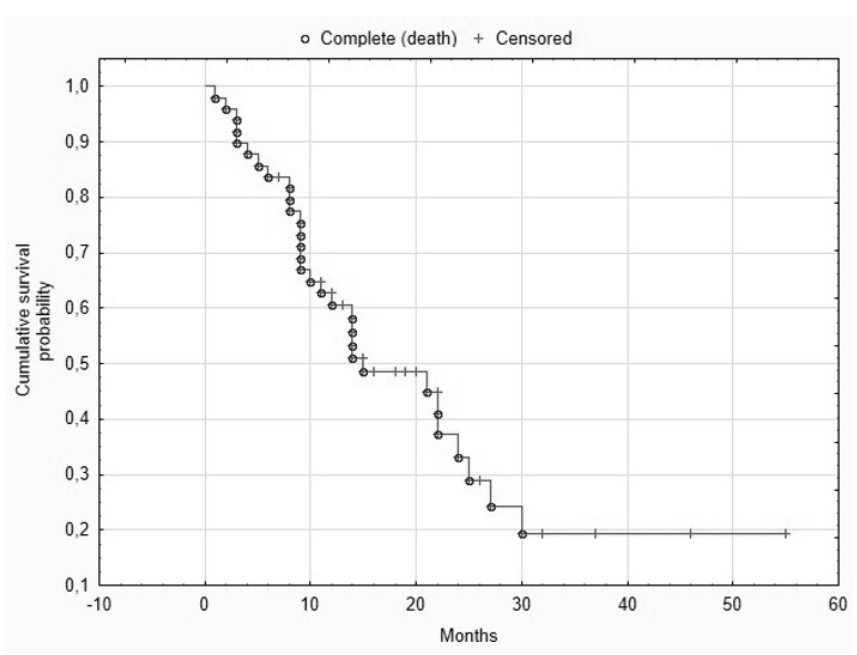
Figure 5. Kaplan–Meier survival analysis for all patients. Post-embolization syndrome was diagnosed following 103 (51%) DEB-TACE treat- ments. In 67 treatments, the severity of PES was low, while after 30 treatments, strong PES symptoms appeared requiring additional treatment (Table Table 3. Branch level of temporary stasis associated with incidence and severity of postembolization syndrome (PES). Branch Level of Stasis